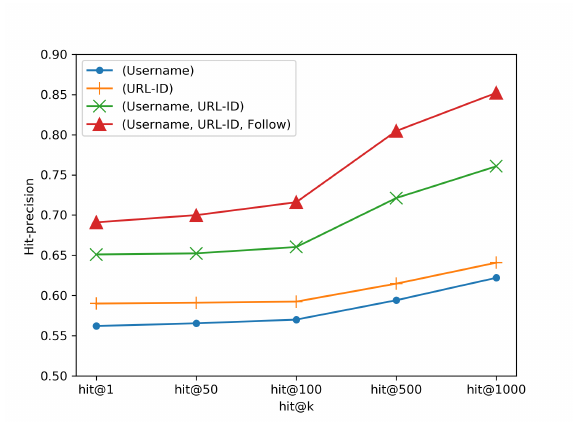
Figure 5. Performance of different feature combinations with an 80% training ratio on the OSCHINA-Gitee